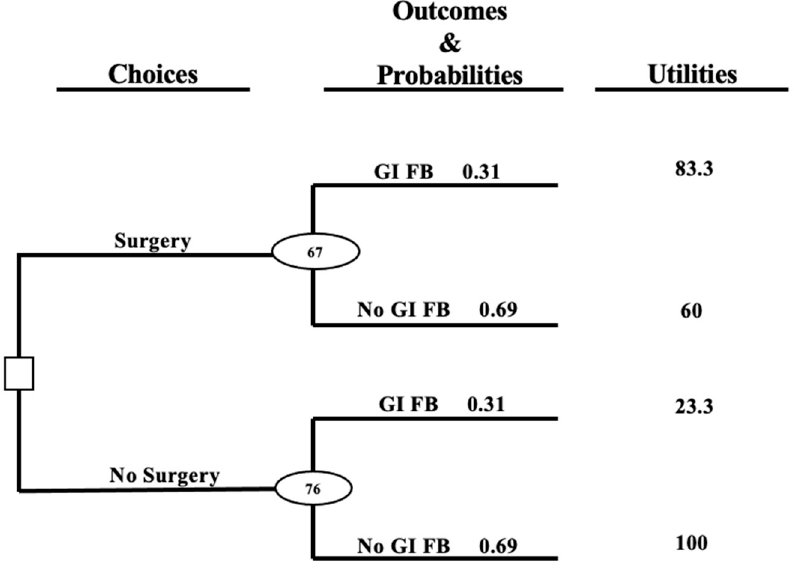
Figure 2. Decision tree for the clinical case of a ferret with a possible gastrointestinal foreign body (GI FB). The square node represents a decision to be made by the clinician, while the oval nodes, called chance nodes, represent the different outcomes dictated by diagnosis probability. The numbers in the oval nodes represent expected values ( ∑ (utility × diagnosis probability)) of each choice. For example, the composite probability of a GI FB at time of surgery (0.31) was multiplied by the utility value of the surgery + GI FB outcome (83.3) to equal 25.8; then the probability of not having a GI FB (1 − 0.31 = 0.69) was multiplied by the utility value of the surgery + no GI FB outcome (60) to equal 41.4. When 41.4 and 25.8 were added together and rounded to the nearest whole number, the expected value of surgery was revealed to be 67. This process was repeated for the “no surgery” choice to reveal an expected value of 76. In this case, the “no surgery” choice provides greater value.